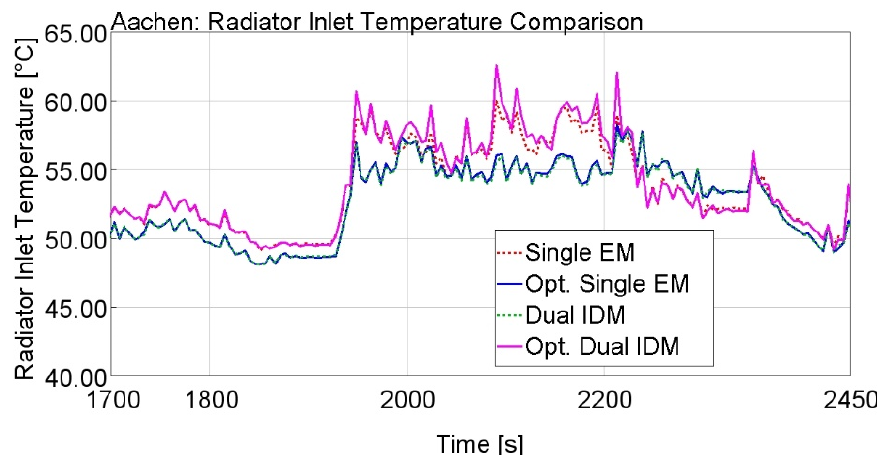
Figure 26. Impact of modularity and optimized control strategy on the coolant temperature at the radiator inlet for the Aachen driving cycle.